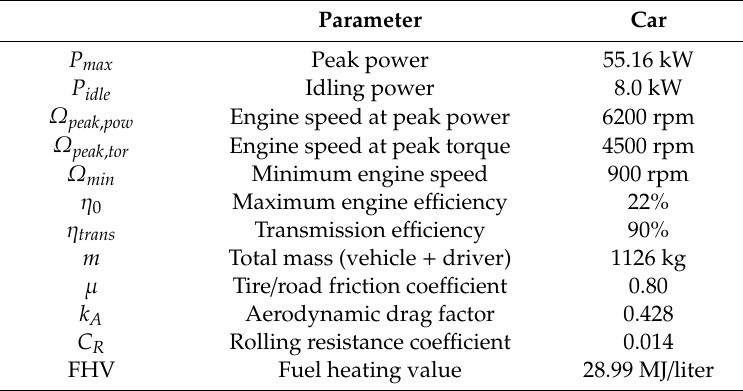
Table 3. Engine and vehicle parameters used for the car